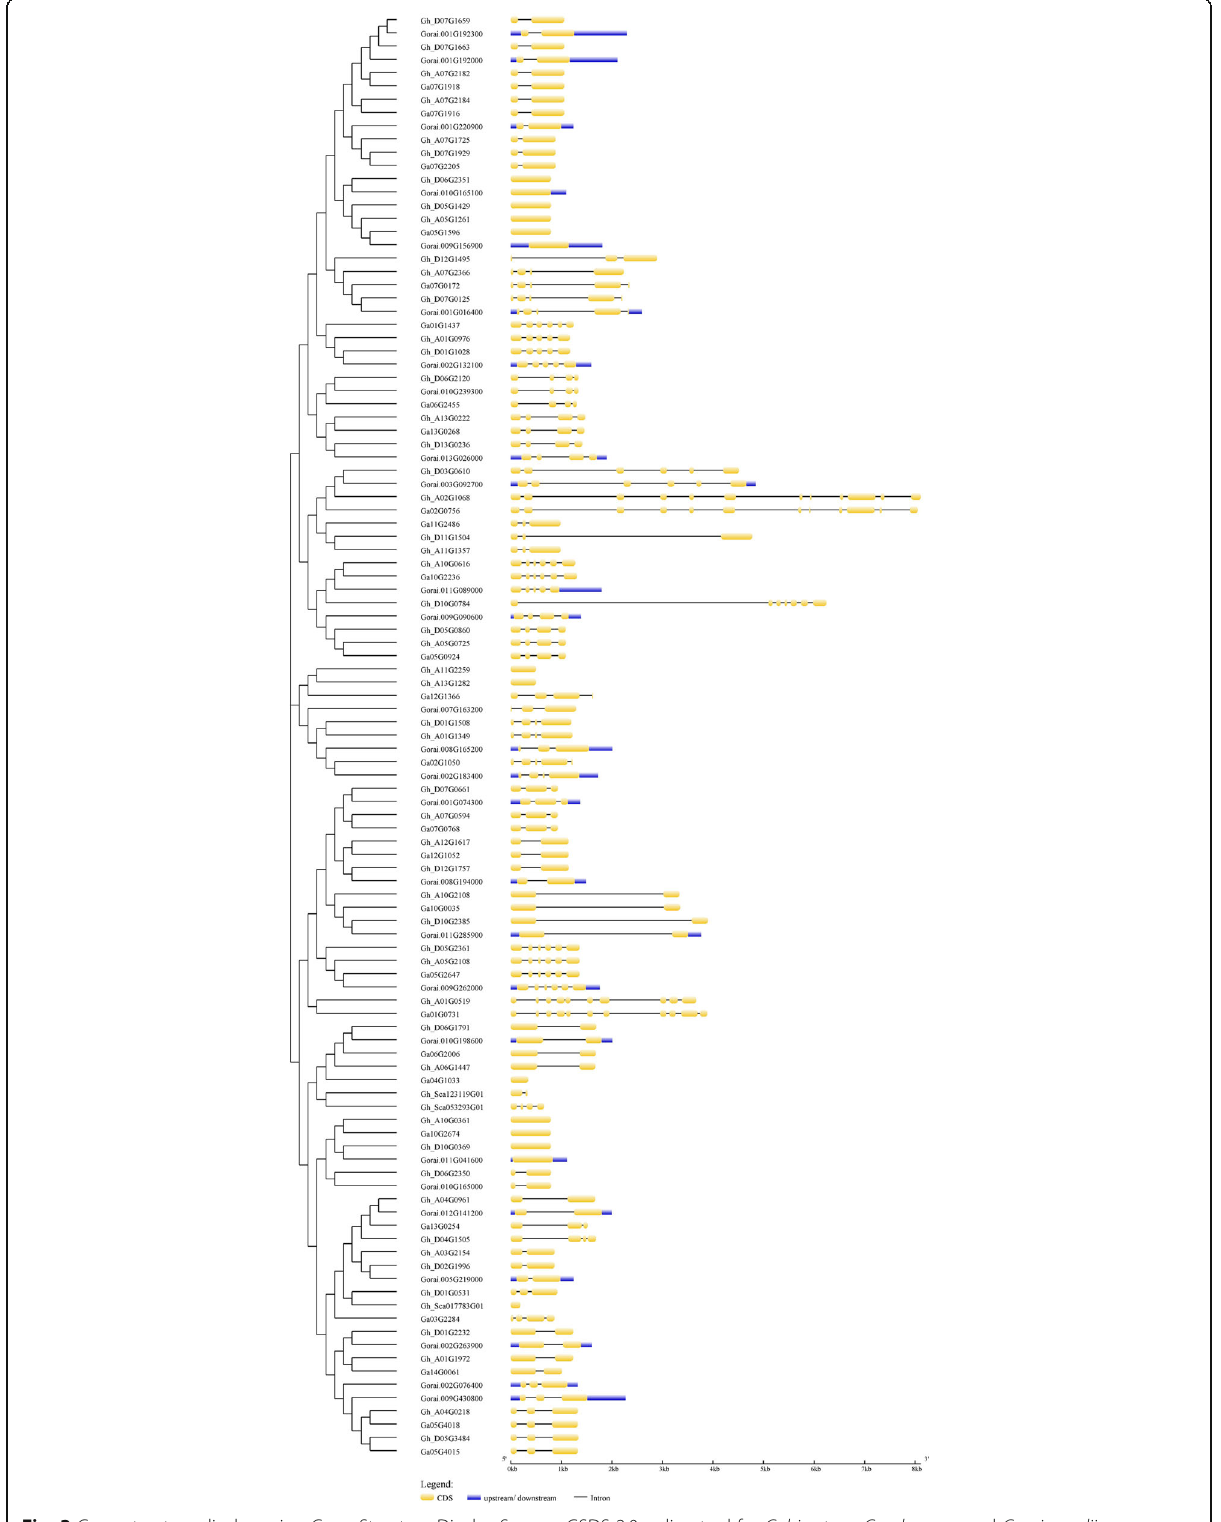
Fig. 3 Gene structure display using Gene Structure Display Server - GSDS 2.0 online tool for G. hirsutum, G. arboreum and G.